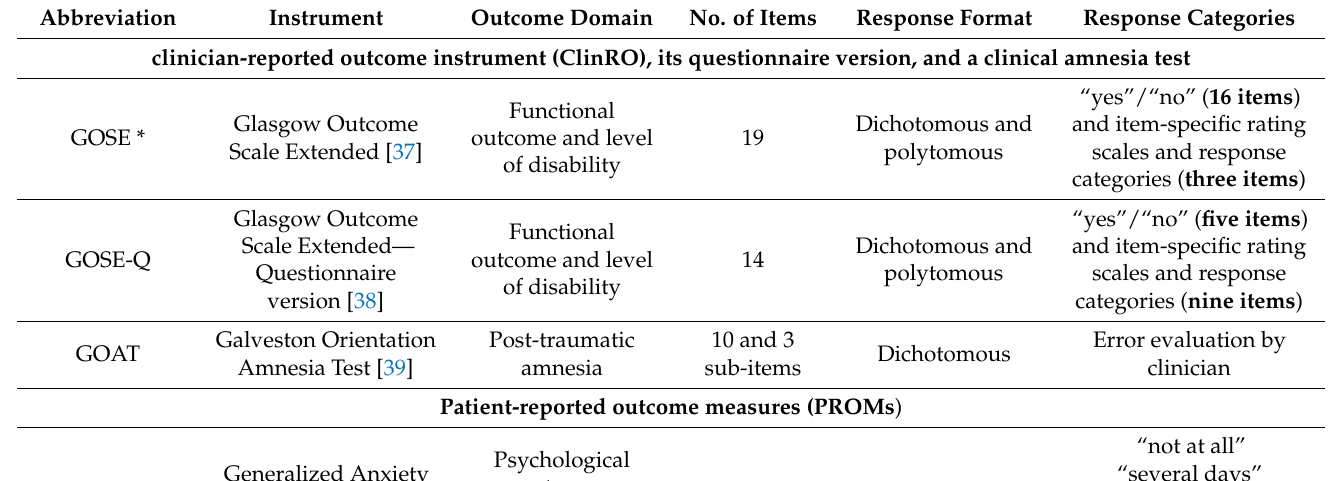
Table 2. Outcome instruments administered in the CENTER-TBI